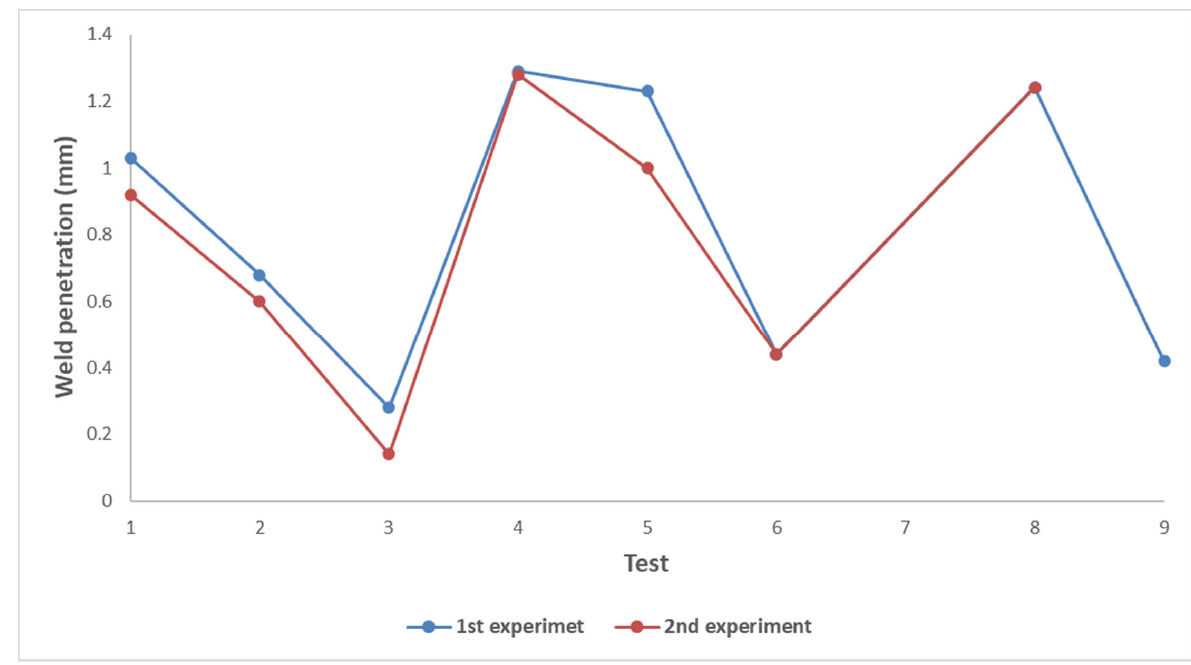
Figure 7. Graphic representation of the average values obtained for welding penetration in experiments 1 and 2.